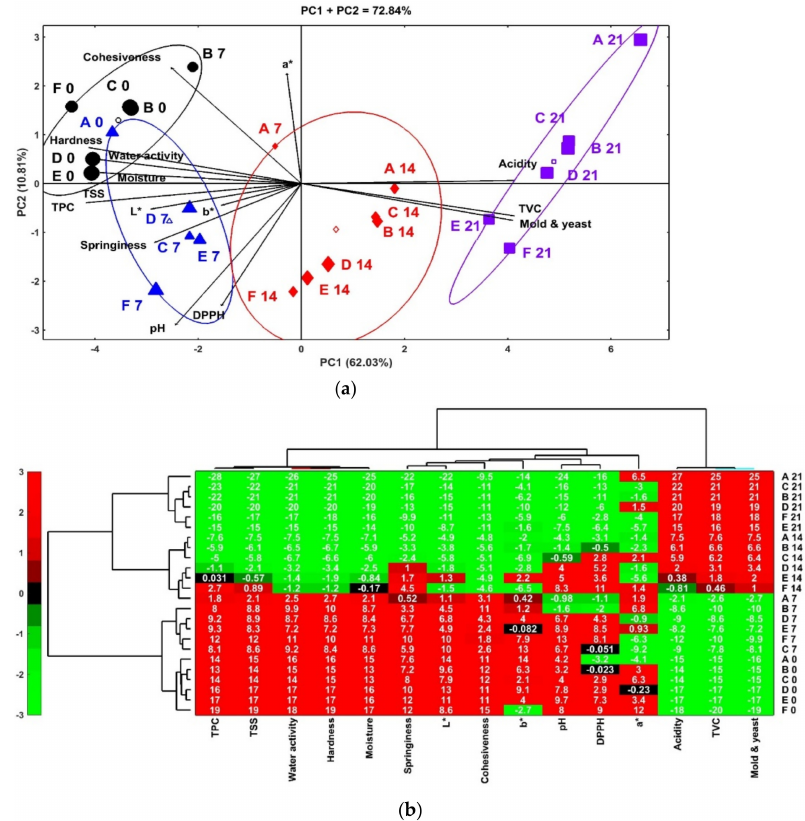
Figure 2. HJ-biplot ( a ) and hierarchical clustering heatmap ( b ) of fresh cucumber coated with chitosan supplemented with different concentrations of olive cake extract (OCE) or orange peel extract (OPE) during cold storage (4 ◦ C) for 0–21 days. A: Uncoated, B: Coated with 2% chitosan only, C: Coated with 2% chitosan containing 1% OCE, D: Coated with 2% chitosan containing 2% OCE, E: Coated with 2% chitosan containing 1% OPE, and F: Coated with 2% chitosan containing 2% OPE. 0, 7, 14, and 21 indicates storage